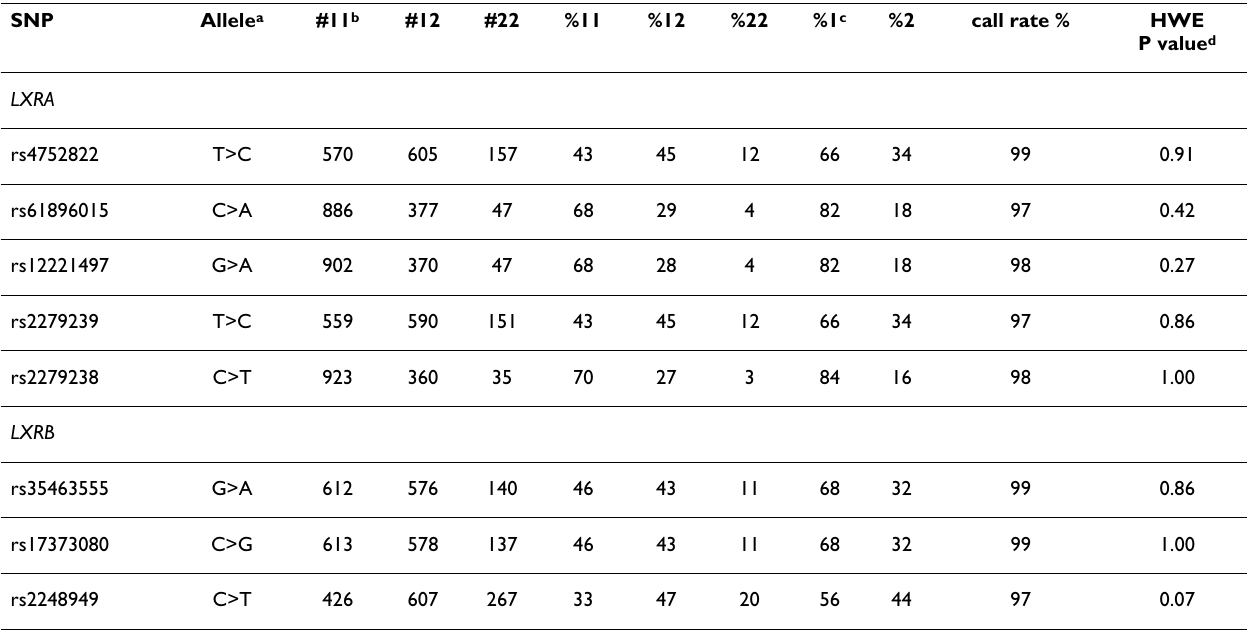
Table 5: LXR genotypes in the Swedish population based SDPP cohort